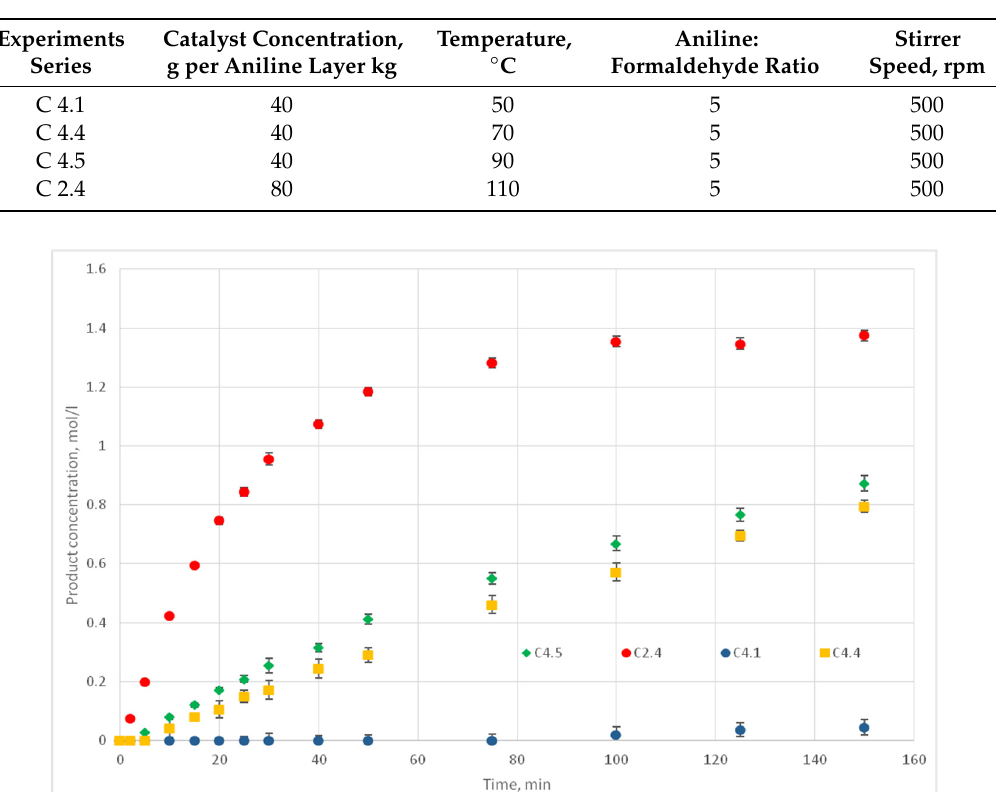
Table 3. С 4.1, 4.4, 4.2 и 2.4 Experimental Conditions. Table 3. C4.1, 4.4, 4.2 и 2.4 Experimental Conditions.